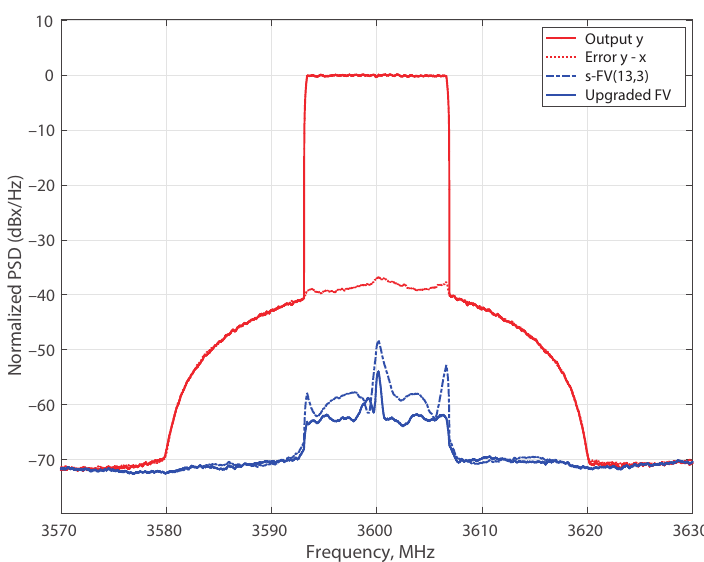
Figure 3. Comparative of the error spectra for the incomplete s-FV(13,3) model and the upgraded FV model (blue traces). Average output level: 19 dBm. All plots have been normalized to make easier comparison with input-output error (red trace).